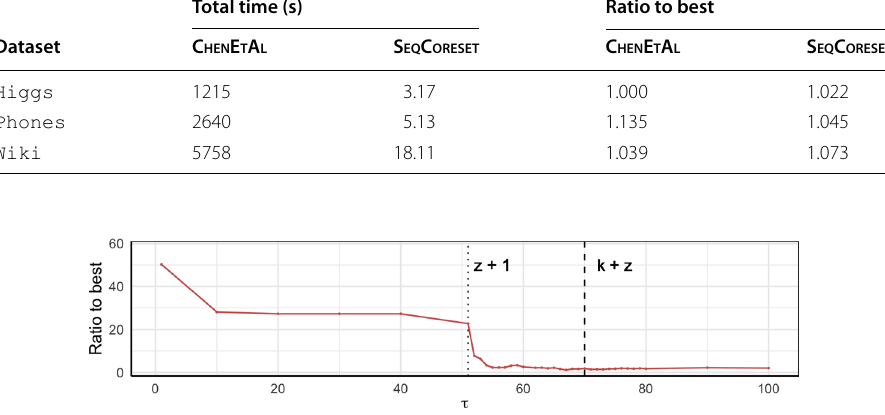
Fig. 2 Ratio to best solution of S eq C oreSet on an instance of Higgs with artificially inserted